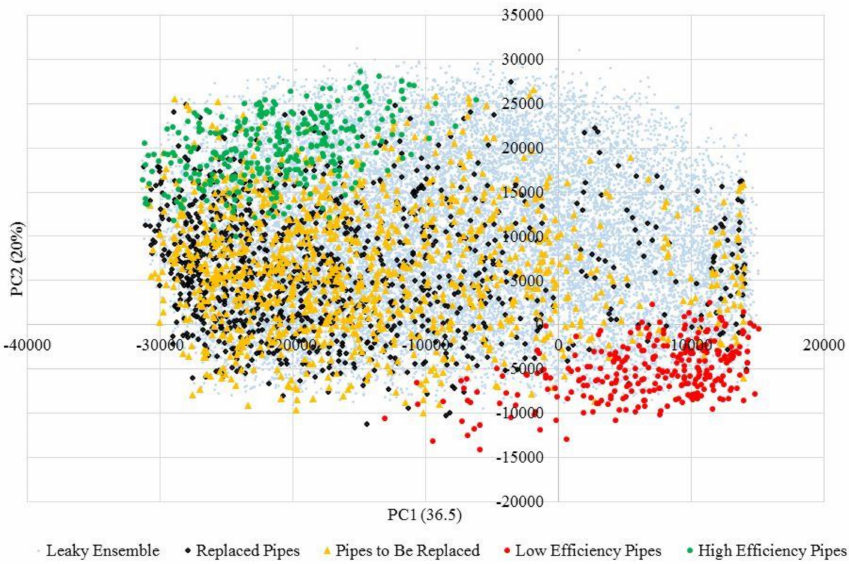
Figure 10. Bi-plot of high/low efficiency clusters compared to common-practice replacement plan by Prosser et al.